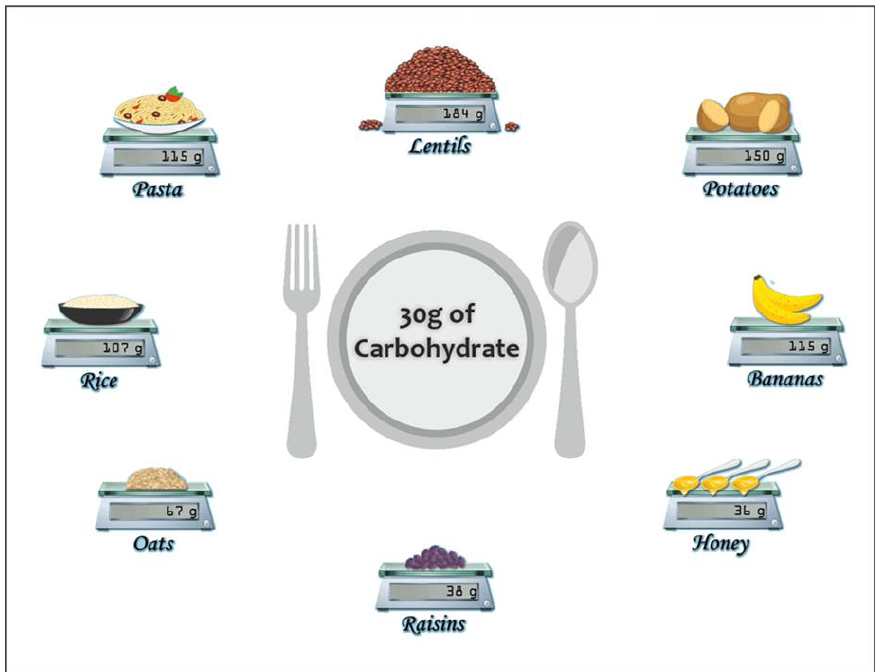
Figure 2. Amount (in g) of food sources that are required to achieve 30 g of carbohydrate (CHO). CHO dense foods such as honey, raisins and oats require far less total food than rice, bananas, pasta, potatoes or lentils to achieve 30 g of CHO.